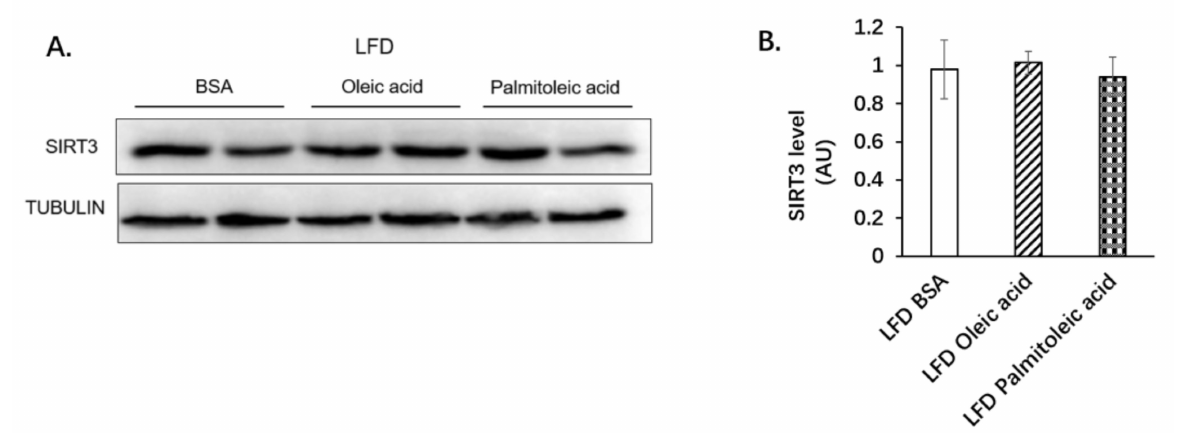
Figure 2. Palmitoleic acid did not alter SIRT3 expression in the liver of mice under LFD. C57BL/6N male mice of 5–6 weeks of age were fed with LFD for 12 weeks. At the 13th week, BSA, oleic acid, or palmitoleic acid was administered intragastrically. At the 18th week, mice were euthanized, and liver tissue was collected. ( A ) Expression of SIRT3 was detected using Western blot analysis. ( B ) Quantification of SIRT3 expression. AU, arbitrary units. The data are mean ± s.e. (error bars). n = 5 mice per